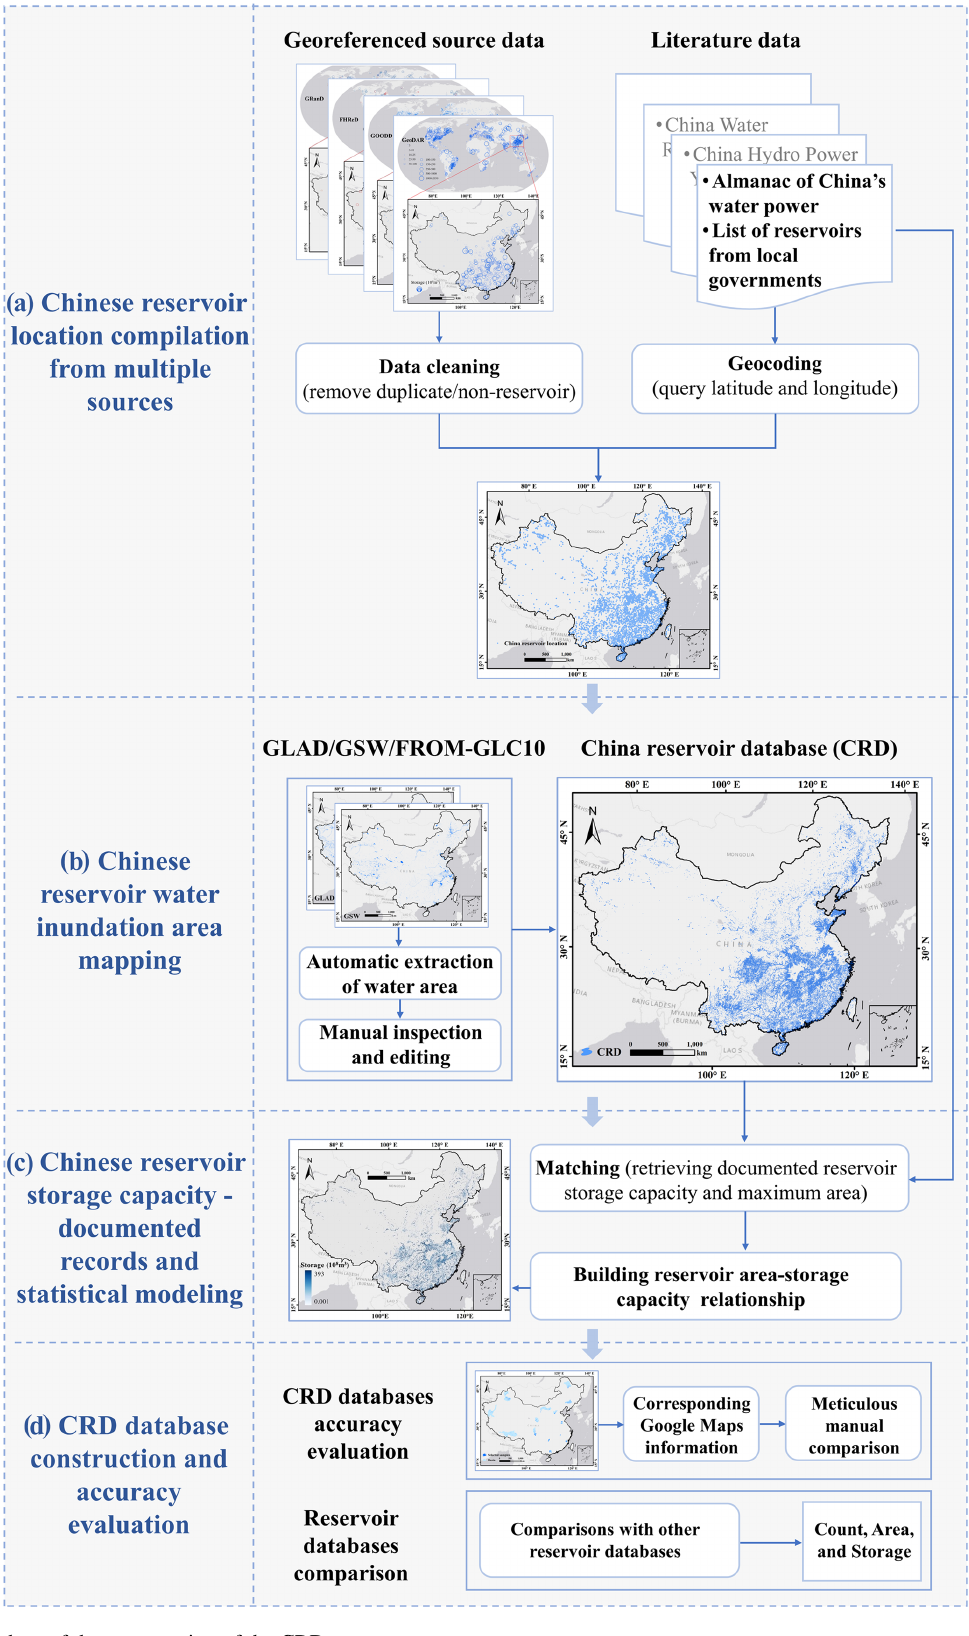
Figure 1. Flowchart of the construction of the CRD. Earth Syst. Sci. Data, 14, 4017–4034, 2022